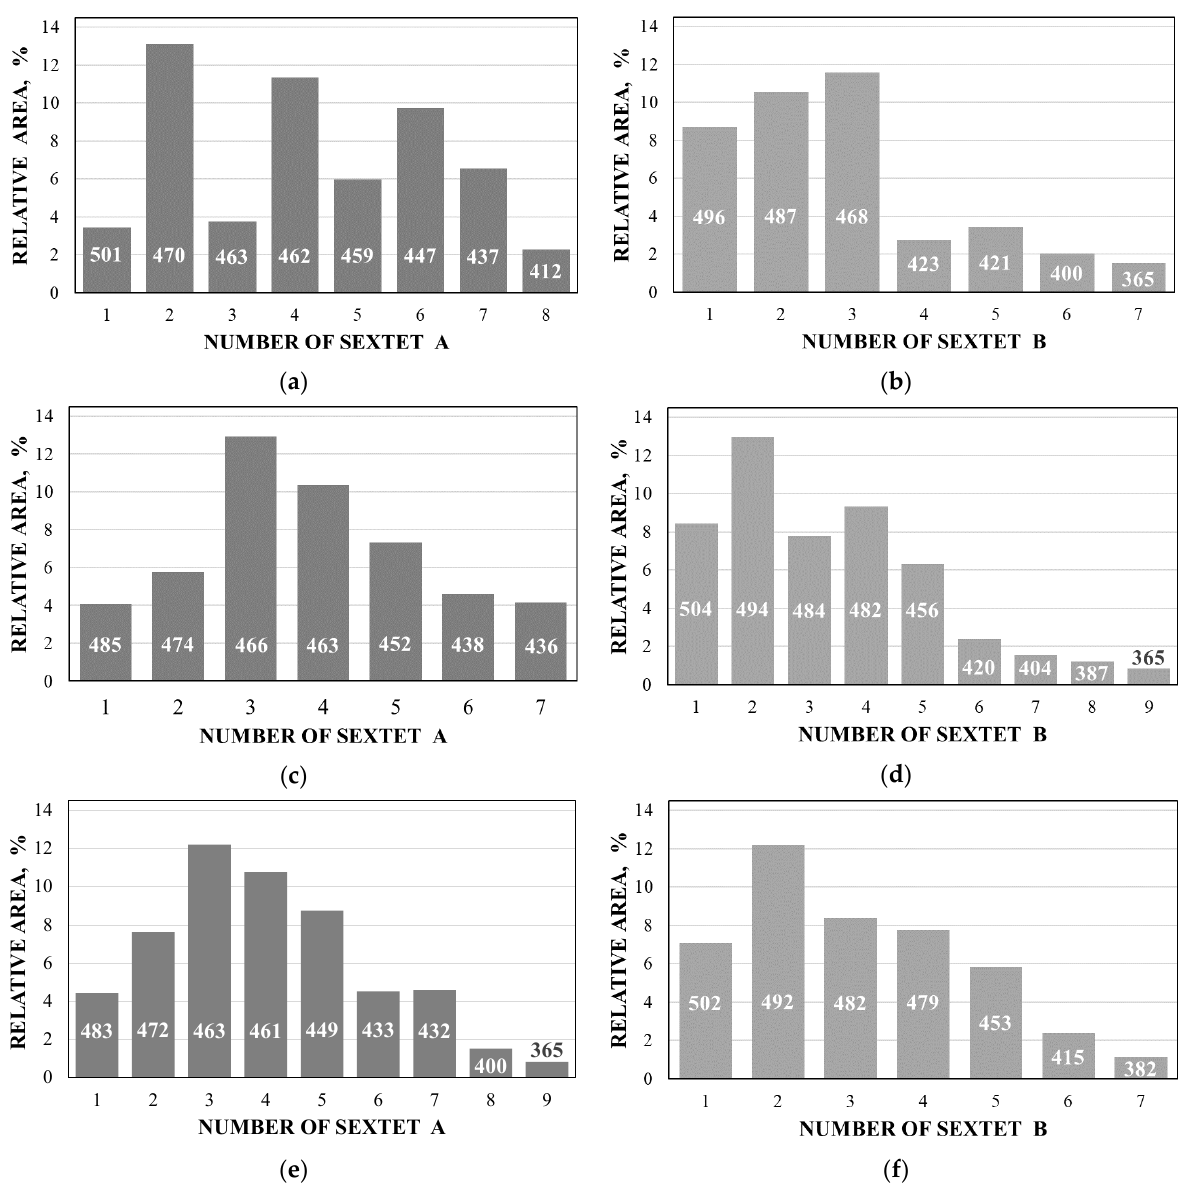
Figure 70. Histograms of the relative areas of magnetic sextets (relative iron fractions) for the corre‑ sponding iron local microenvironments in MFO1 ( a , b ), MFO2 ( c , d ) and MFO3 ( e , f ) resulting from the different numbers of Mg 2+ cation in the Fe 3+ local microenvironments in both tetrahedral ( a , c , e ) and octahedral ( b , d , f ) sites in MgFe 2 O 4 nanoparticles. Numbers of sextets are the same as numbers of spectral components in Figure 69. The values of H eff in kOe are shown for each sextet. Adapted from Ref. [94] with permission from Elsevier: Journal of Alloys and Compounds, Vol. 912, Ushakov M.V., Nithya V.D., Rajeesh Kumar N., Arunkumar S., Chukin A.V., Kalai Selvan R., Oshtrakh M.I., “X‑ray diffraction, magnetic measurements and Mössbauer spectroscopy of MgFe 2 O 4 nanoparticles”, 165125,